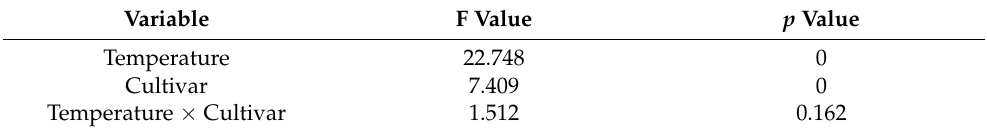
Table 4. Two-way ANOVA on TP